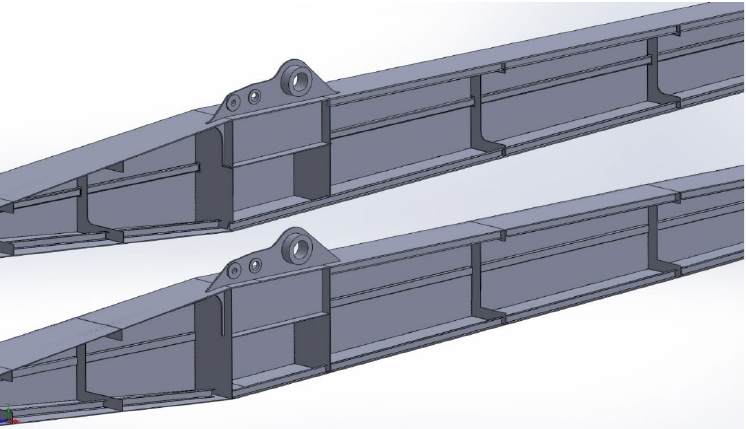
Figure 2. Details of modeling for the internal structure of the boom.